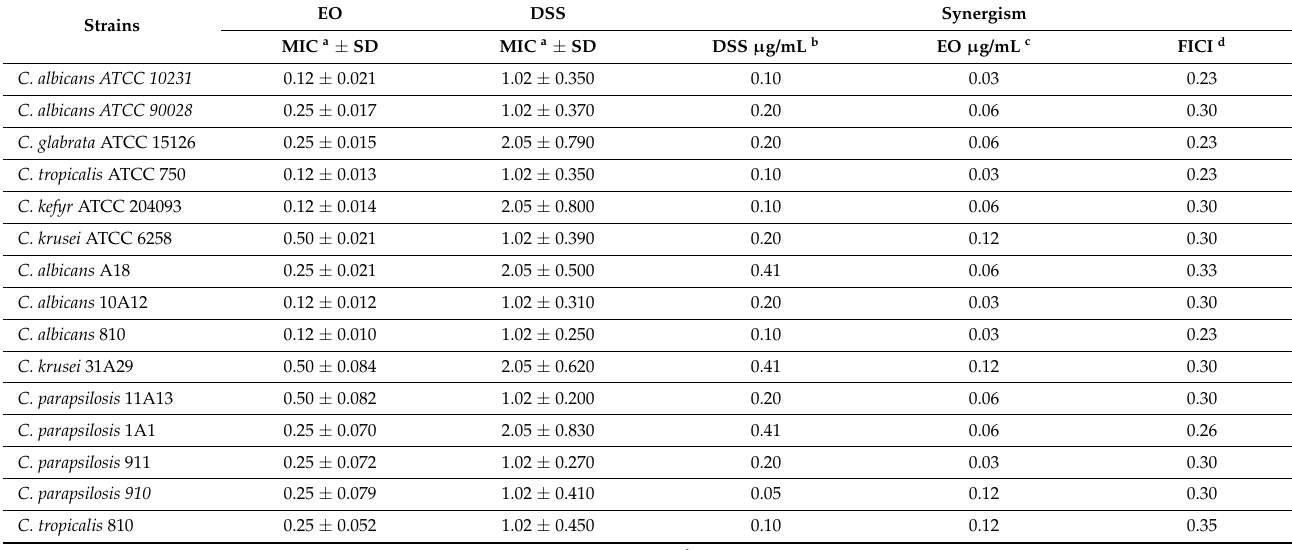
Table 3. Antifungal activity of P. graveolens Essential Oil (EO) and Diclofenac Sodium Salt (DSS) on different Candida strains. Strains